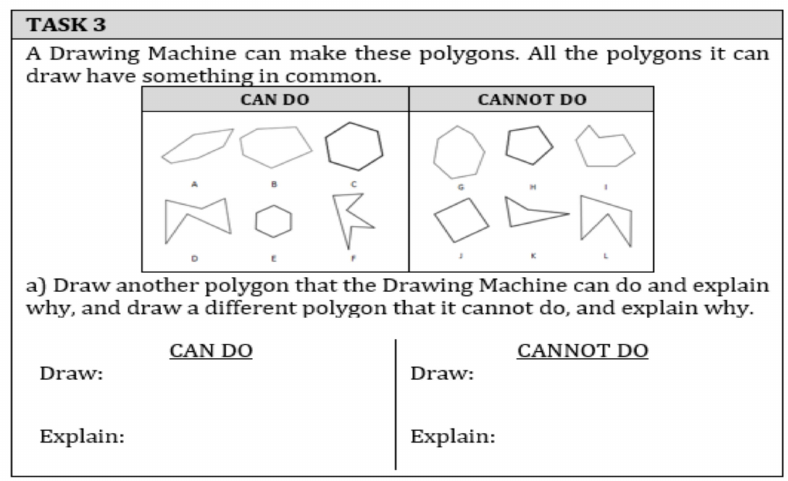
Figure 1. Example of a task in the questionnaire and initial interview: identify the attribute that defines a class (having 6 sides) and represent examples and non-examples of the class.